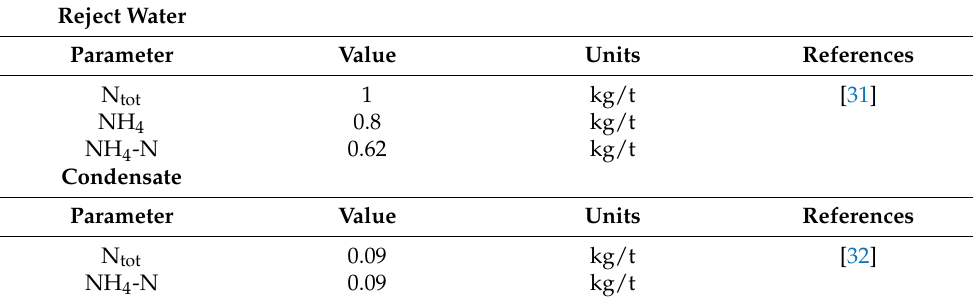
Table 3. Reject water and condensate properties.